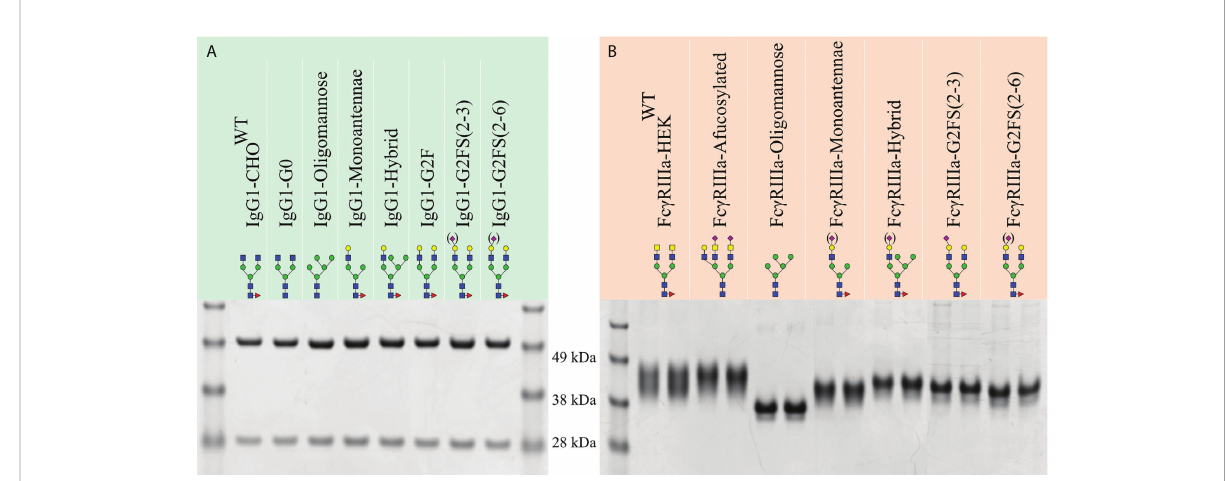
FIGURE 2 SDS-PAGE of puri fi ed recombinant IgG1 and Fc g RIIIa-158F/V. Reducing SDS-PAGE of 1 m g puri fi ed (A) glycoengineered IgG1 produced in CHO cells with the heavy chain and light chain at ~50 and 30 kDa, respectively. (B) HEK293-expressed His- and AviTag-tagged Fc g RIIIa-158F (left lane) and -158V (right lane) migrating as a broad band with a molecular weight ranging from 40 to 50 kDa. Designations for monosaccharides according to the CFG are indicated (51).